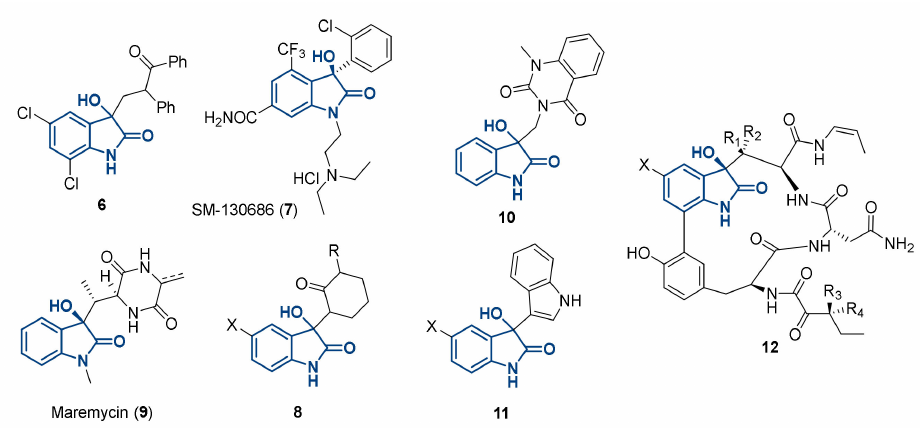
Figure 2. Examples of 3-hydroxy-2-oxindoles derivatives described in